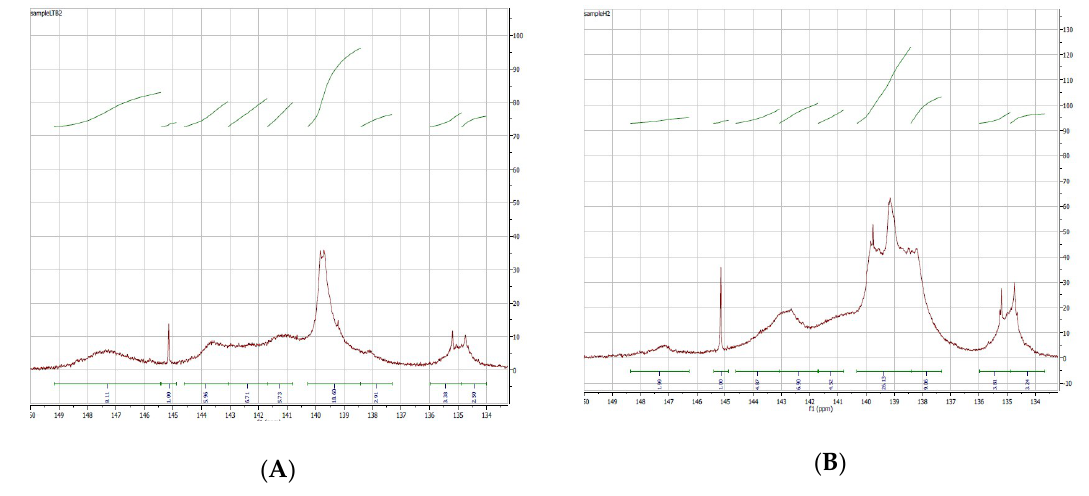
Figure 6. 31 P NMR spectra of ( A ) the control (KL) and ( B ) the DKL of Run #H2.